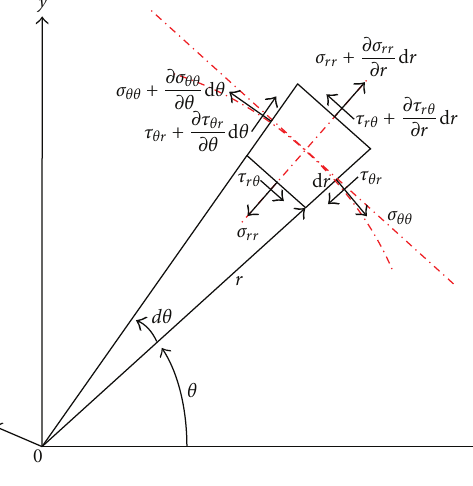
Figure 4: Stress analysis of di ff erential element.